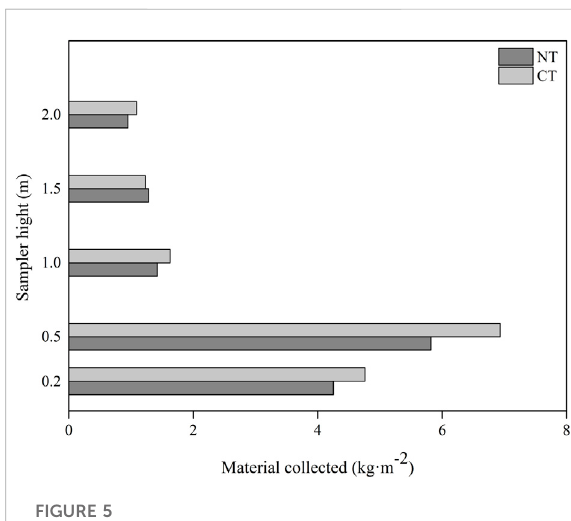
FIGURE 5 Total erodible particles (saltation) by the rBSNE sampler